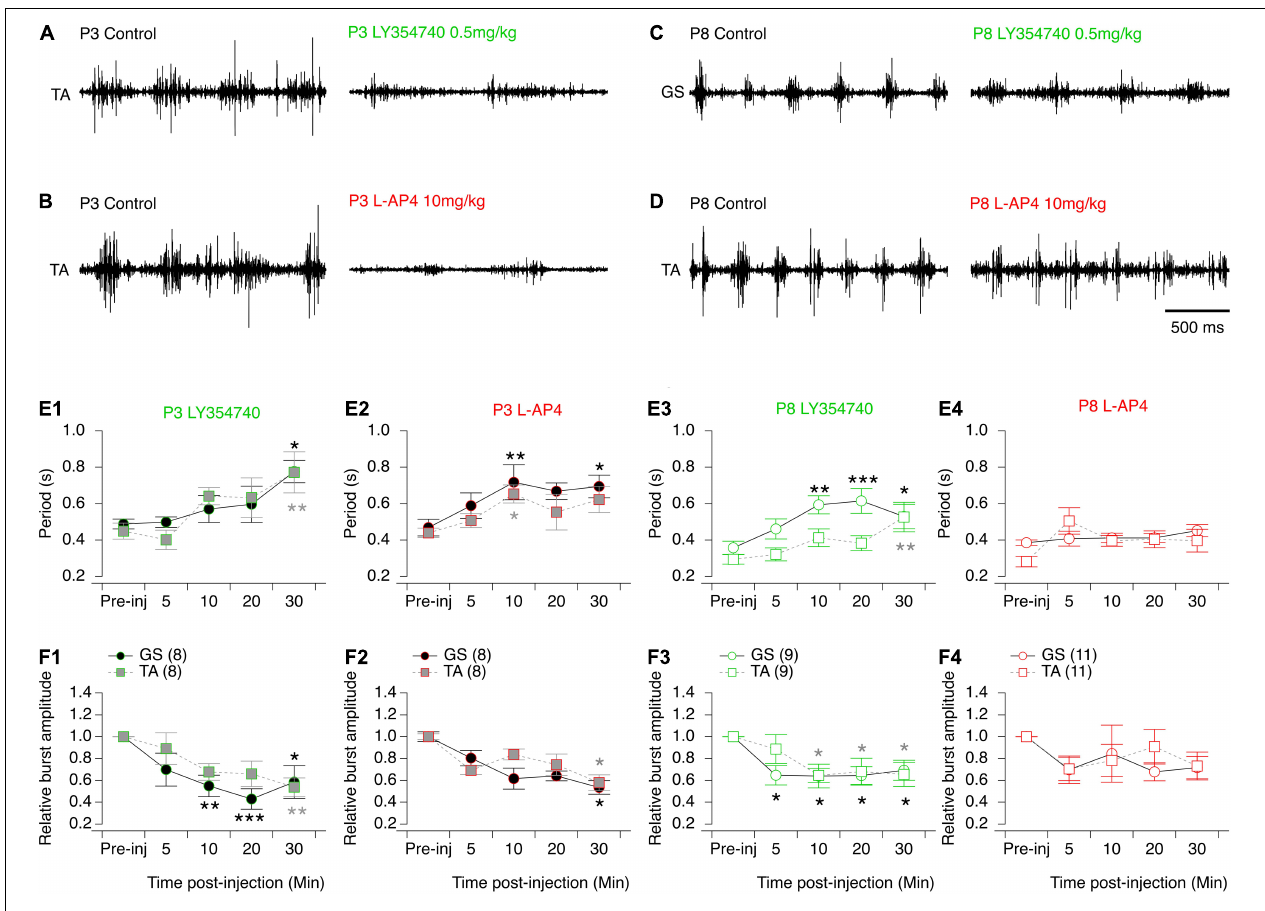
FIGURE 9 | Effects of the mGluRII and III agonists on spontaneous swimming activity in mice. (A–D) Representative electromyographic recordings from a hindlimb Tibialis Anterior (TA) or Gastrocnemius (GS) muscle before (control) and 30 min after the injection of LY354740 (A–C) or L-AP4 (B–D) in P3 (A–B) and P8-P10 (C–D) mice. (E) Cycle period of the swimming activity recorded from the GS (circles) or TA (squares) before (pre-inj) and at different time points (5, 10, 20, and 30 min) after the injection of LY354740 (E1–E3) or L-AP4 (E2–E4) . (F) Same data representations as in (E) for swimming burst amplitudes normalized to the mean amplitude values before mGluR agonist injection. Note that LY354740 and L-AP4 significantly altered both the period and motor burst amplitudes of the swimming activity of P3 mouse pups. In contrast, in P8 animals such effects were only found significant following the injection of LY354740. Numbers into brackets correspond to the number of animals tested. Two-way RM ANOVA followed by Sidak’s post hoc tests. * p < 0.05; ** p < 0.01 and *** p < 0.001 significantly different from the pre-injection cycle